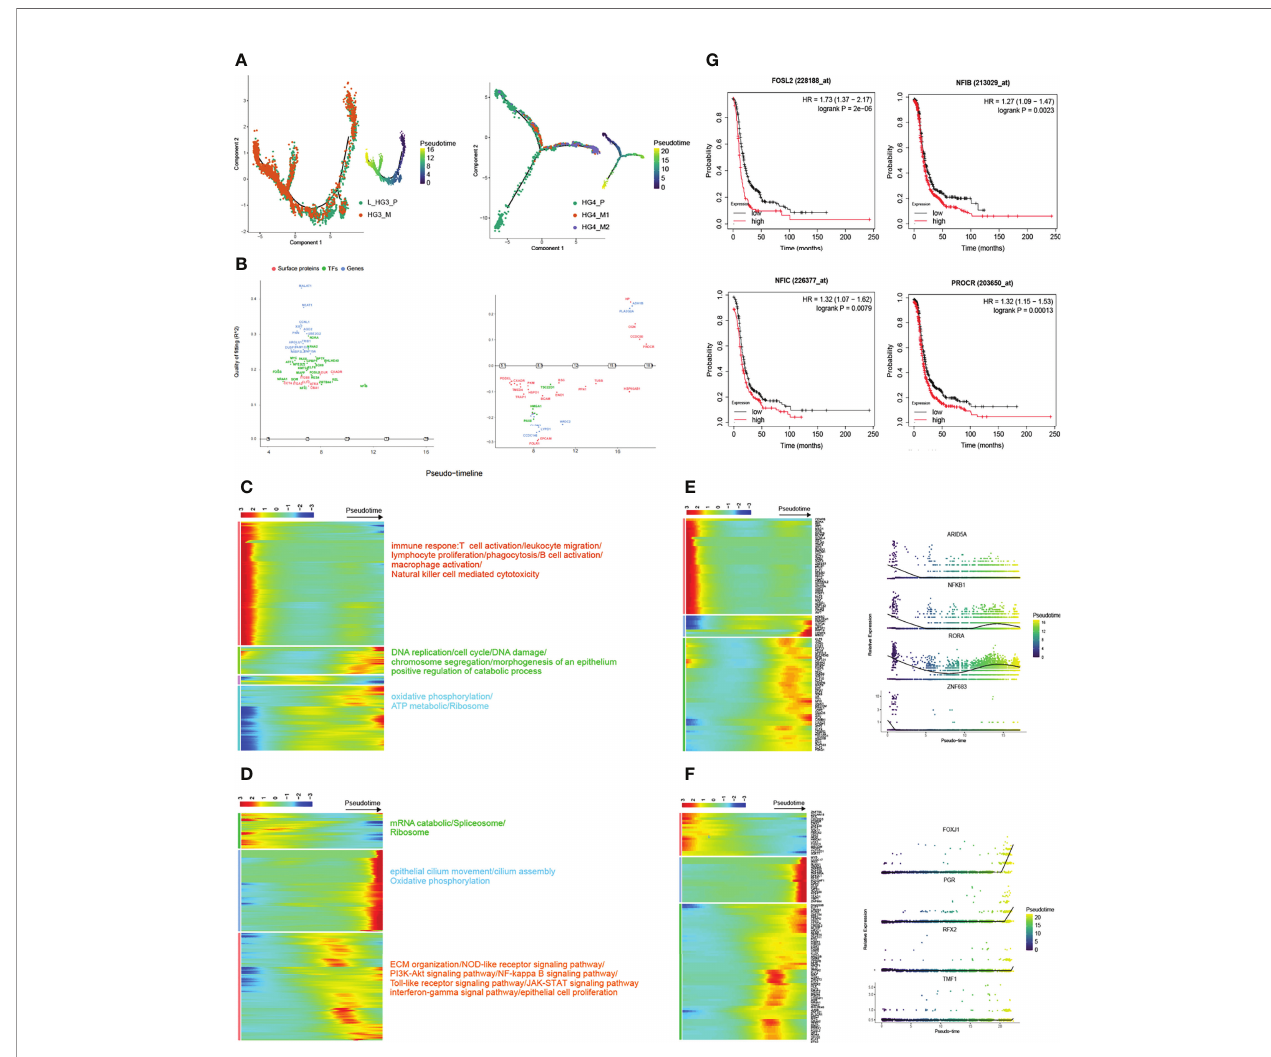
FIGURE 3 | Trajectory reconstruction during metastatic HGSOCs. (A) Monocle2 infers the development of epithelial cells along with pseudo-time (from patients HG3 and HG4 respectively, L_HG3_P means the primary tumor from the left ovary). Pseudo-time legend from dark to bright indicates cancer progression from the early to late stage. (B) Genswitches deduces the genes switch between cell states (left: L_HG3; right: HG4). (C , D) The heatmap displays the dynamic gene expression pro fi les during metastasis of ovarian cancer (from patients HG3 and HG4 respectively). The color key from blue to red indicates relative expression levels from low to light. The top annotated GO and KEGG terms in each cluster are shown. (E , F) Top 100 differentially expressed transcription factor genes (TFs; left) and the expression of speci fi c TFs are on view along with the pseudo-time curve in (right). (G) Overexpression of proliferation and metastasis-related genes predicts poor prognosis in